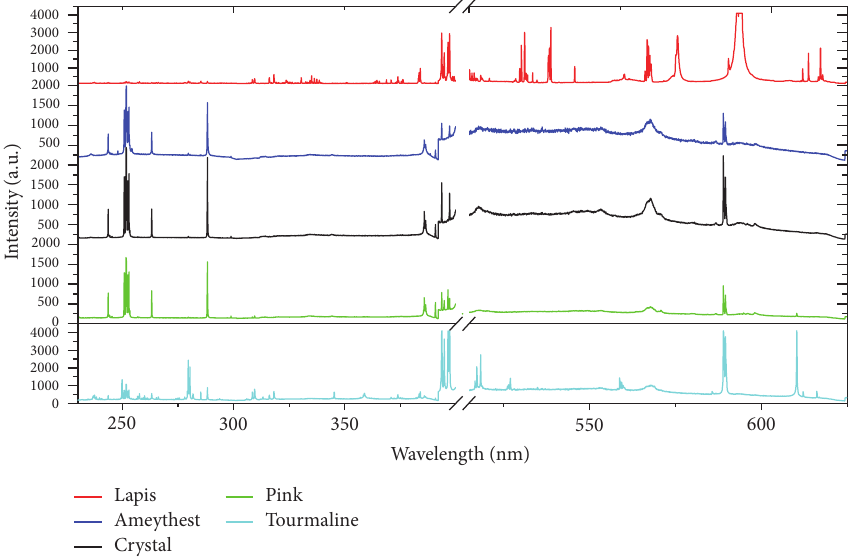
Figure 3: Plot showing a comparison between optical emission spectra of all the collected quartz samples.